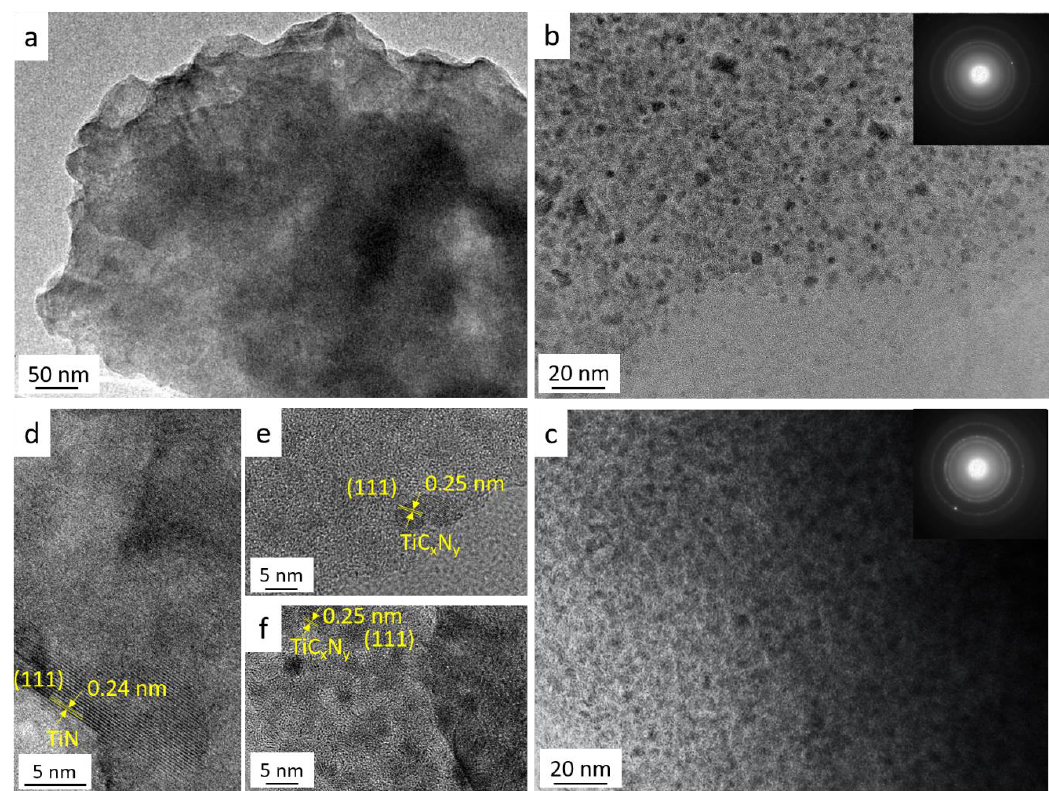
Figure 13. TEM images of P-1400NH ( a , d ), P-1400N ( b , e ) and the P-1400A samples ( c , f ) with inserted selected area electron diffraction patterns in ( a – c ).